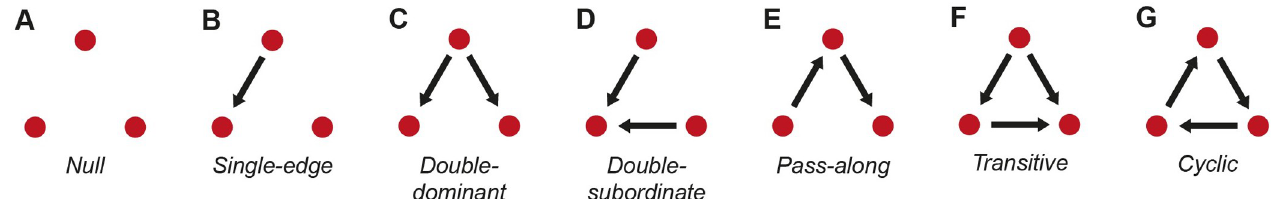
Fig 1. Motifs of directed relations in a triad. Motifs A to E are partial triads, motifs F and G are complete triads. Individuals in motif F can be ranked. Therefore, motif F is transitive. Individuals in motif G cannot be ranked and therefore, it is intransitive